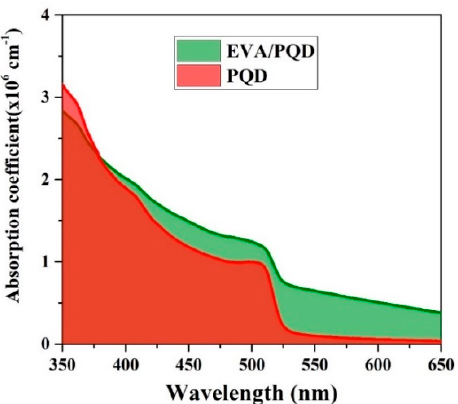
Figure 6. Absorption coefficients of the pure PQD and the EVA-TPR/PQD films. The complex refractive index (N = n + ik) is a function of two parts, real and imaginary, where n is the real part of the refractive index and k is the imaginary part. The k value can be determined from experimentally measured parameters such as α ( λ ) using the equation k = αλ /4 π , and the n( λ ) value can be calculated in terms of R using n = (1+ R)/(1 R) for the perpendicular incidence of light with respect to the film plane [43]. The wavelength-dependent functions k( λ ) and n( λ ) are presented in Figure 7a,b, respectively, for the pure and composite thin films. The profiles were identical to those of the absorption coefficient, with a shoulder at 506 ± 2 nm (508 nm for pure and 504 nm for composite), and k( λ ) increased with increasing photon energy (decreasing wavelength). The value of k( λ ) at the shoulder was approximately 0.039 and 0.049 for the pure and composite PQDs, respectively, which shows that the extinction efficiency of the EVA-TPR/PQDs was 25.6% higher than that of the pure PQDs; hence, EVA-TPR/PQDs are an attractive option for optoelectronic devices such as solar cells. Moreover, if proper pumping is applied, it could also serve